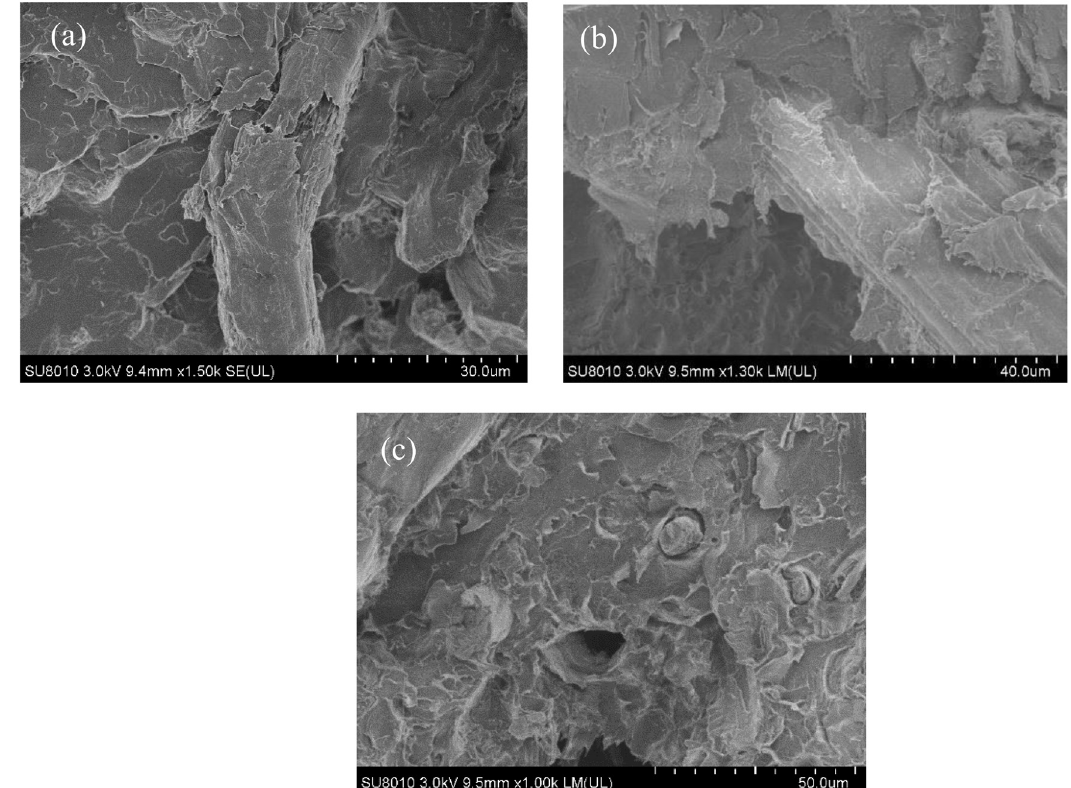
Figure 8: SEM micrographs of fracture surface of biocomposites: ( a ) PLA/BP - 60, ( b ) PLA/BP - 100 and ( c ) PLA/BP - 200.